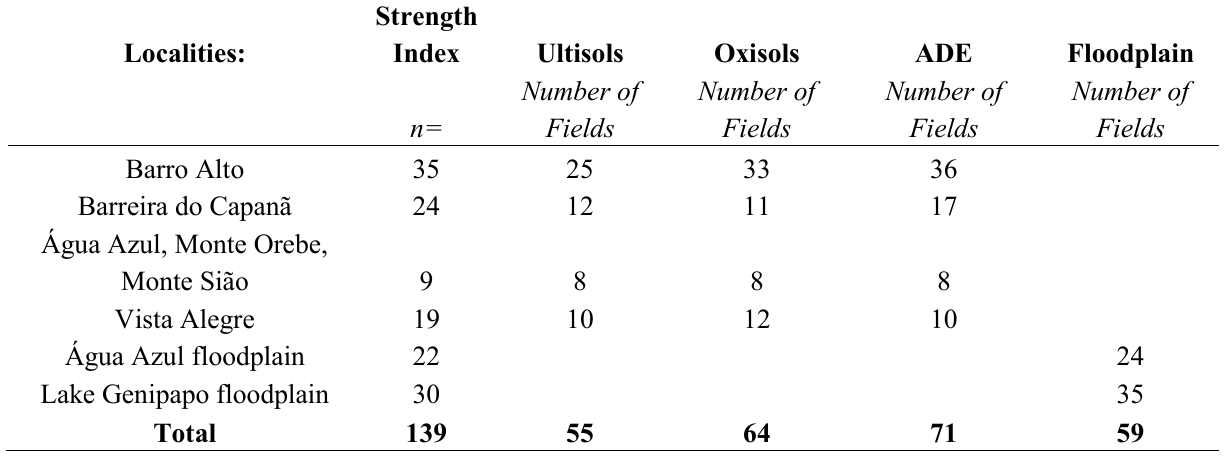
Table 1. Manioc dataset: Communities, number of informants (n=) that contributed to strength index, and number of bitter manioc fields in each kind of